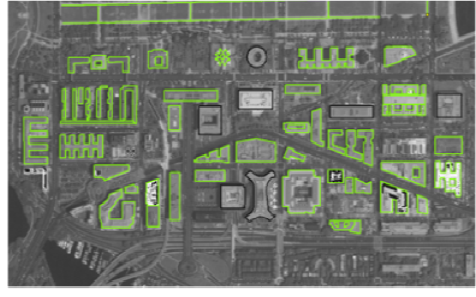
manual digitization. This is performed in the following steps, igitize manually in the proximity of the inten ded building. efine the edges that are manually digitized in step -1 by densifying and constructing a neighbourhood of each of these points and searching for real edges in canny edge